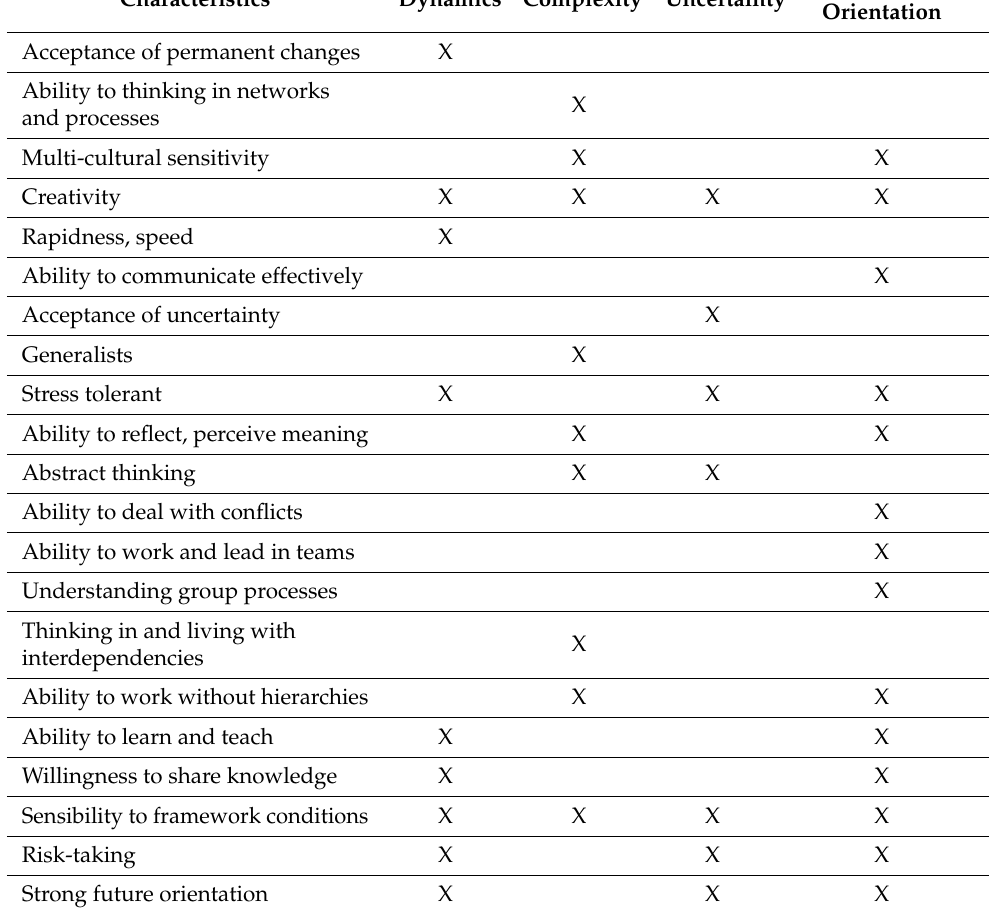
Table 2. Characteristics of high dynaxibility. The allocations to the terms dynamics, complexity, uncertainty and people-orientation are marked with an X. Source: own, based on [11,12].